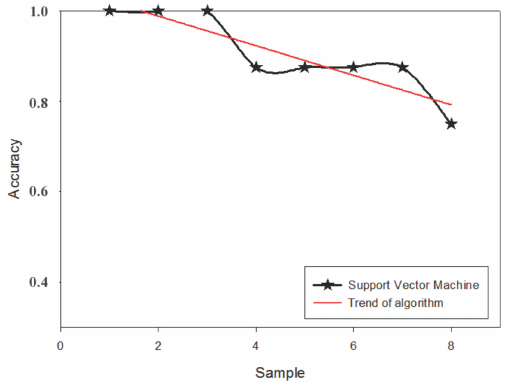
Figure 12. Support vector machine algorithm for marine fuel system fault diagnosis.